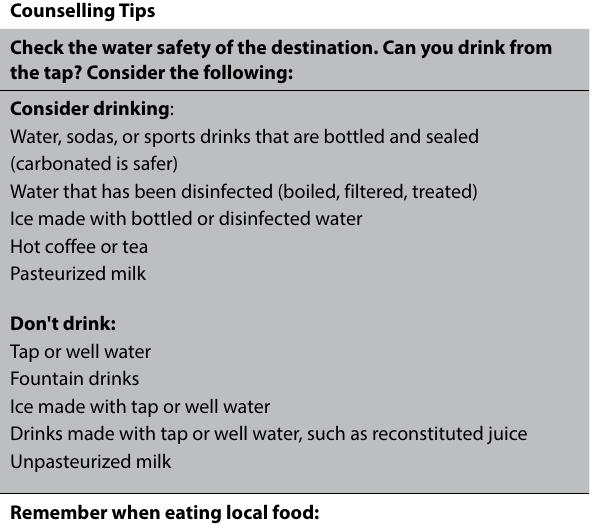
Table 2: General advice to be provided to the client Counselling